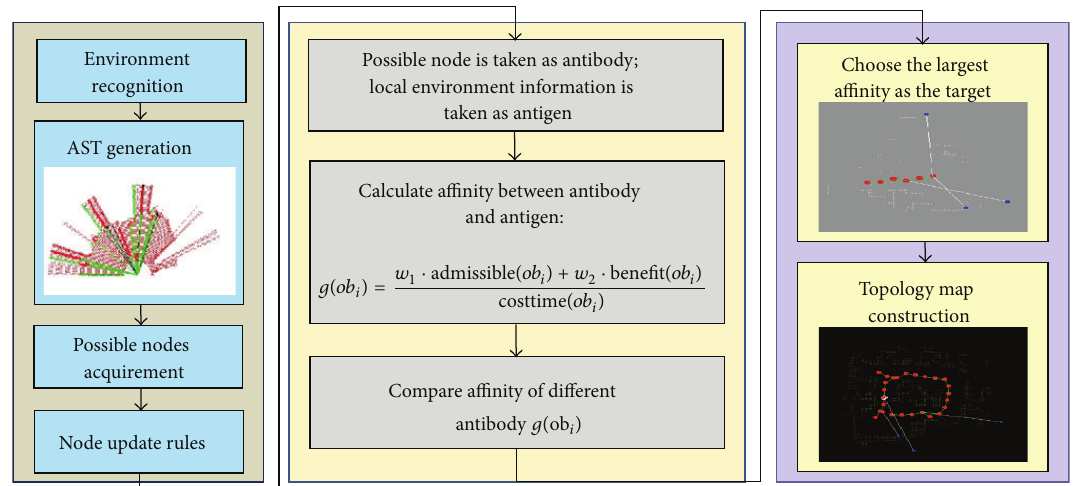
Figure 1: Details of immune system application on mobile robot.